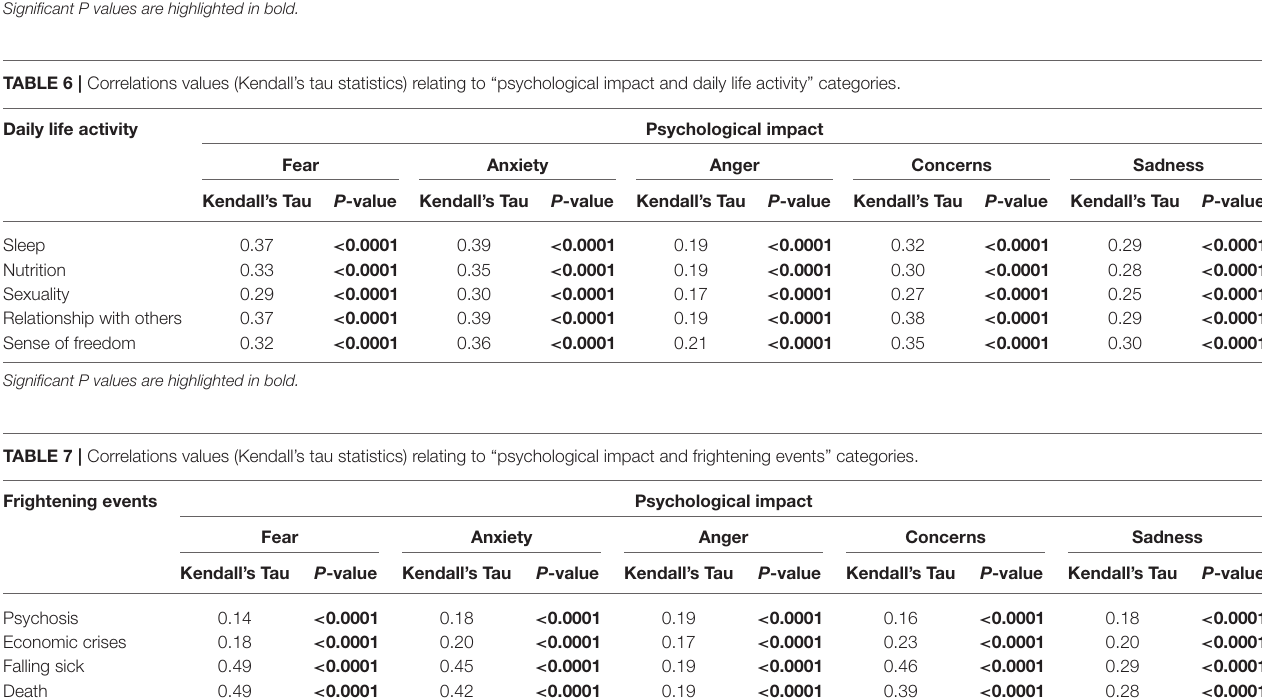
Significant P values are highlighted in bold.